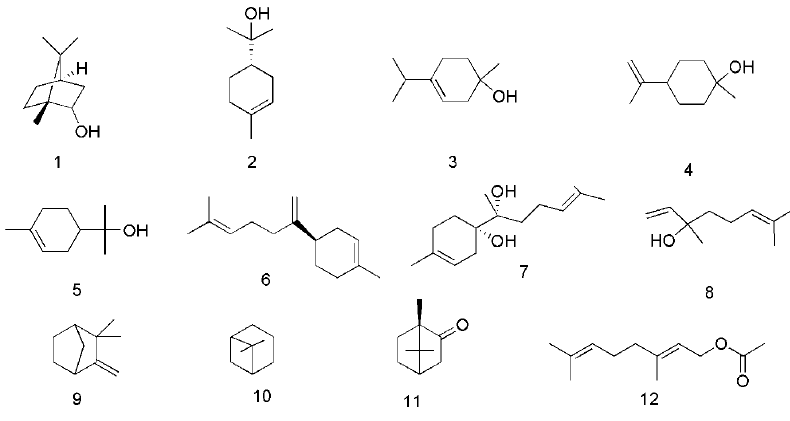
Figure 2. Chemical structures of the monoterpenes in C. cassia .